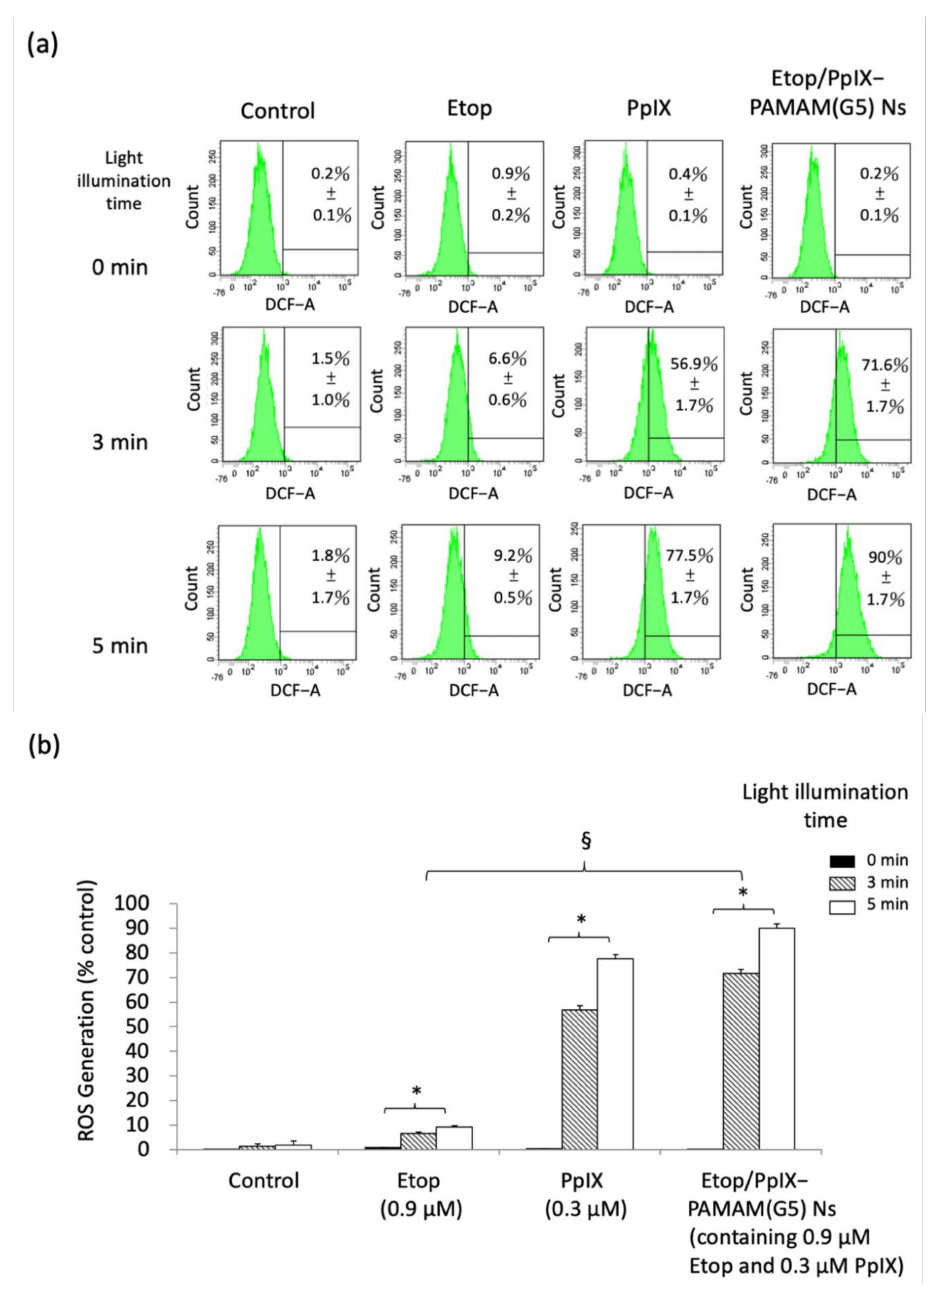
Figure 10. The generation of intracellular ROS in U87-MG cells following treatment with Etop (0.9 µ M), PpIX (0.3 µ M) PDT, and Etop/PpIX-PAMAM(G5) Ns (containing 0.9 µ M Etop and 0.3 µ M PpIX) PCI were analyzed using flow cytometry of oxidized DCFH-DA; the oxidized fluorescent product DCF corresponds to the redox state of the cells, which is assumed to be proportional to the concentration of ROS in the cells. ( a ) The single parameter histogram showed the percentage of cells with DCF fluorescence with varying treatment; the percentages ranged from 0.87% to 9.2% for Etop, 0.37% to 77.53% for PpIX PDT, and 0.23% to 90% for Etop/PpIX-PAMAM(G5) Ns PCI from 0 min to 5 min light illumination. ( b ) Significant increases in the proportion of cells bearing DCF fluorescence were observed across all treatments following light illumination; these were positively correlated to the light illumination time with Etop/PpIX-PAMAM(G5) Ns PCI showing significantly higher percentages than all other treatments. * p < 0.05 (differences within treatment group). § p < 0.05 (differences in between treatment groups using the same light illumination time). (DCF—dichlorofluorescein,